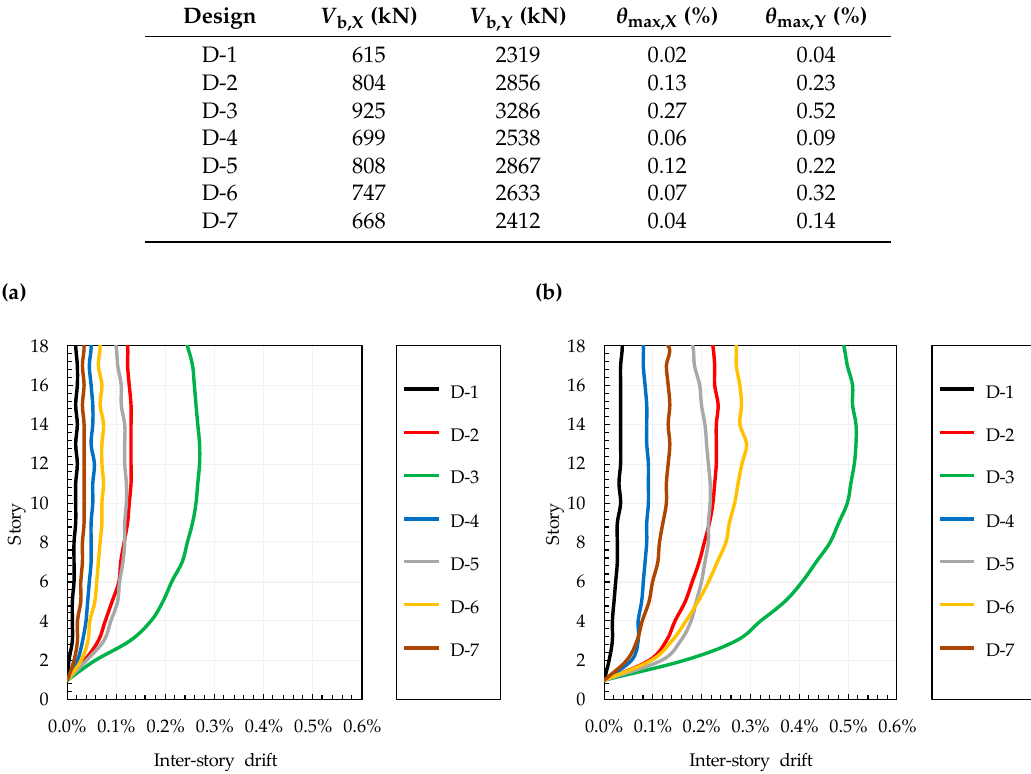
Figure 8. Inter-story drift profile for the X -direction ( a ) and Y -direction ( b ) under wind loads.